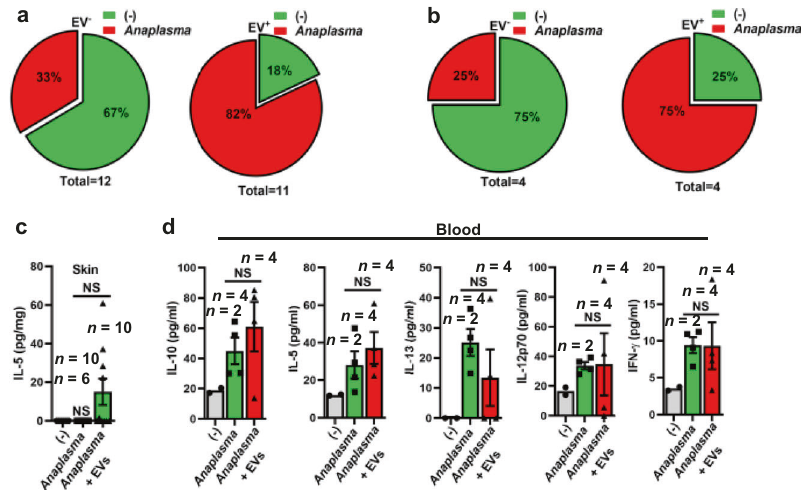
Fig. 7 I. scapularis EVs enable A. phagocytophilum infection in the mammalian host. A. phagocytophilum (1 × 10 7 ) was intradermally injected in the presence or absence of I. scapularis salivary gland EVs (4 × 10 7 ). The presence (red) or absence (green) of A. phagocytophilum in a skin or b spleen was measured by quantitative real-time PCR at day 3 post-infection. Cytokine measurements were done in the mouse c skin and d blood by a multiplex ELISA assay. Baseline treatment denotes skin and mouse blood without bacterial infection (gray bars). Data is presented as a mean and standard error of the mean (±SEM). ( *p < 0.05; NS not signi fi cant). Graphs are representative of one in two independent experiments. Statistics in c were done by using one- way ANOVA, whereas d was done by two-tailed t -test between Anaplasma and Anaplasma + EVs. For c n = skin samples and d n = blood samples. Source data are provided as a Source Data fi